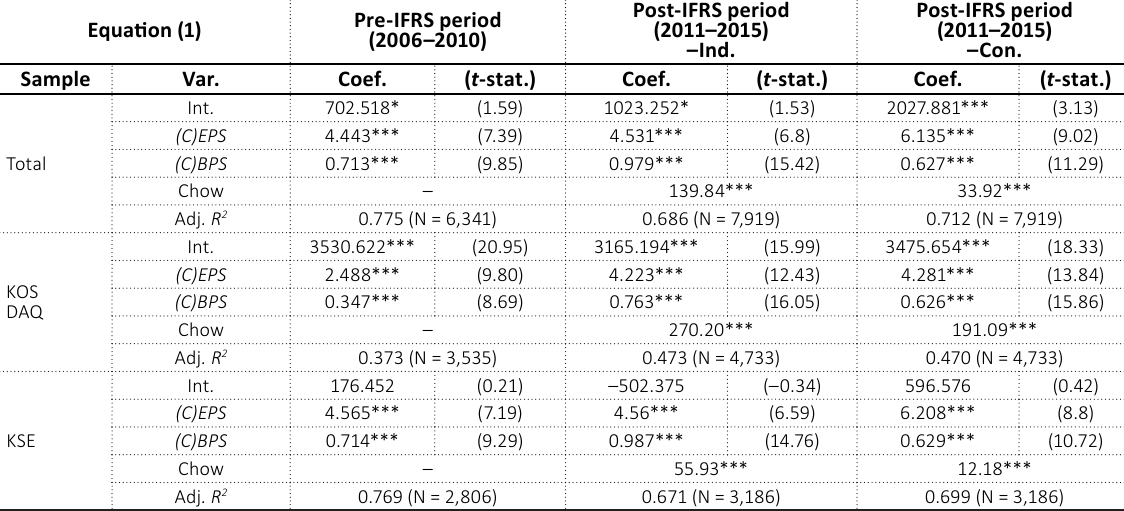
Table 3. Test results of hypothesis using pooled OLS model (Equation (1)) Equation